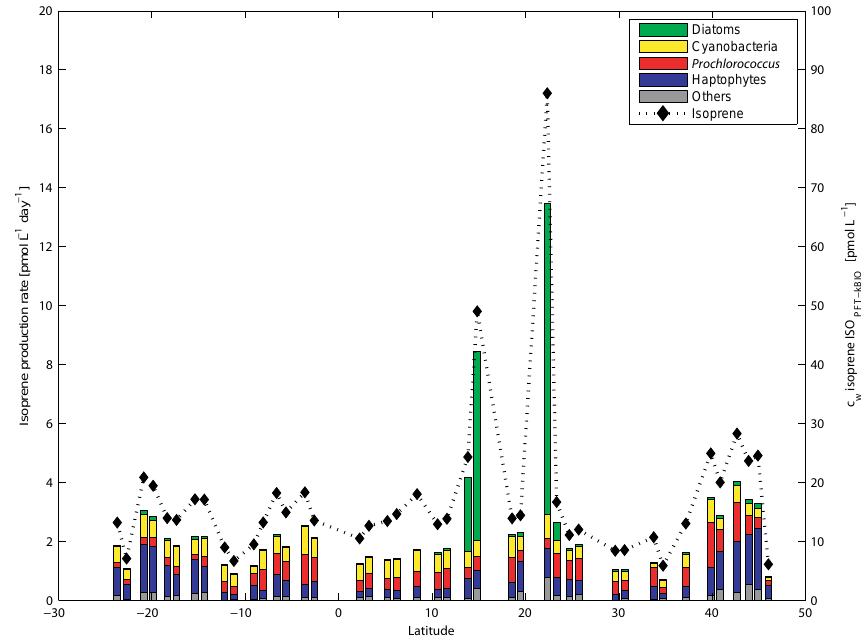
Figure 5. Proportion of main PFTs contributing to the total isoprene production rate for each station during